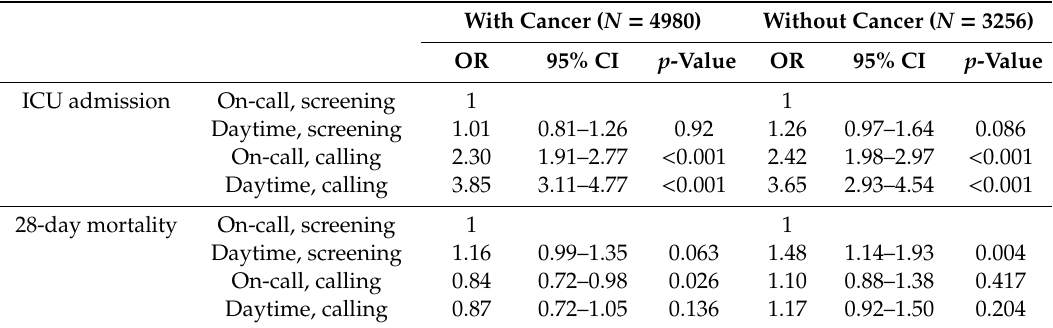
Table 2. Clinical outcomes among medical patients without cancer and with cancer.